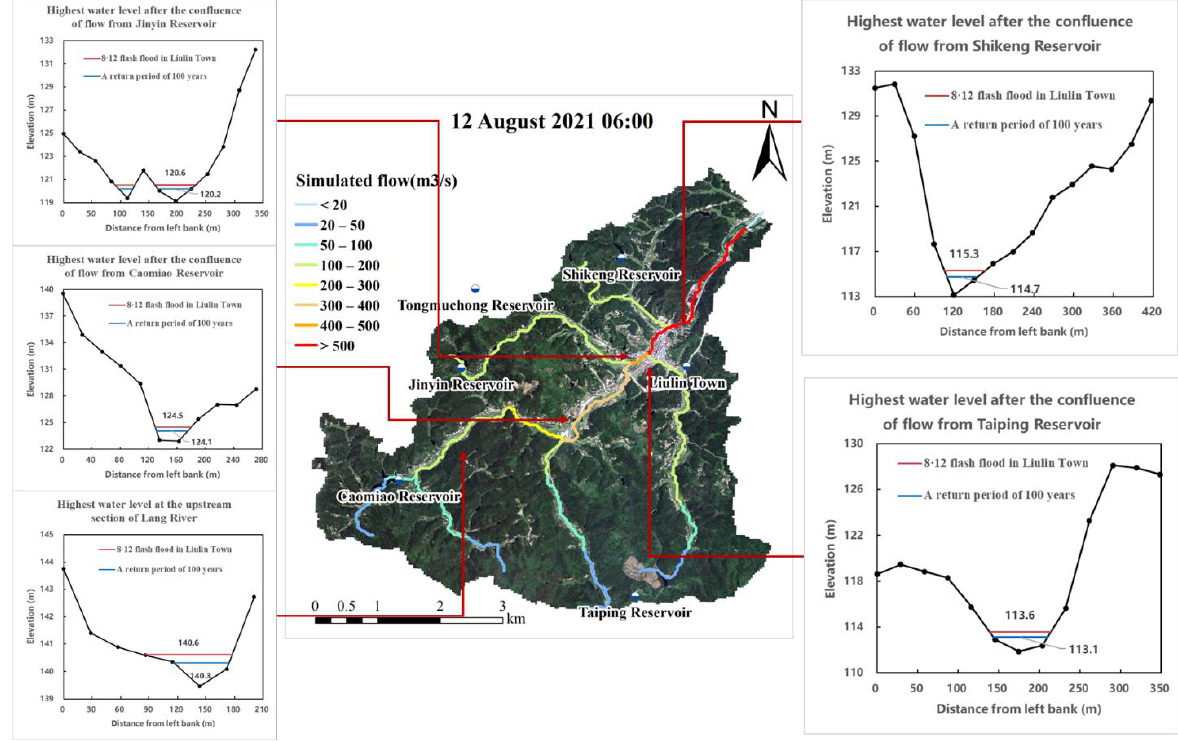
Figure 10. Simulated water levels of various reservoirs.